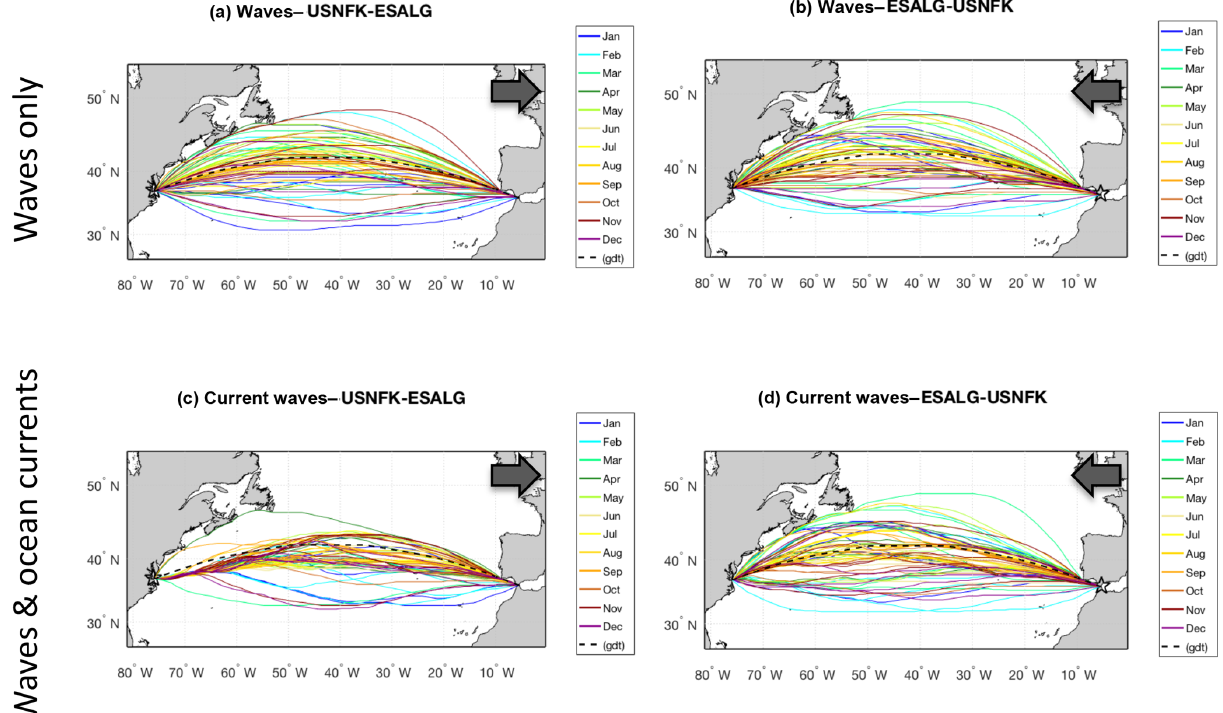
Figure 7. Route tracks of the same transatlantic crossing of Fig. 5 during the calendar year 2017. Panels (a) and (b) refer to w type; (c) and (d) refer to cw-type tracks. Both east- (left) and westbound tracks (right) are shown. The geodetic route is displayed as a black dashed line. Animations of the panels are available at https://av.tib.eu/series/560/gmdd+18 (last access: 12 July 2019). For this and other routes, see also the